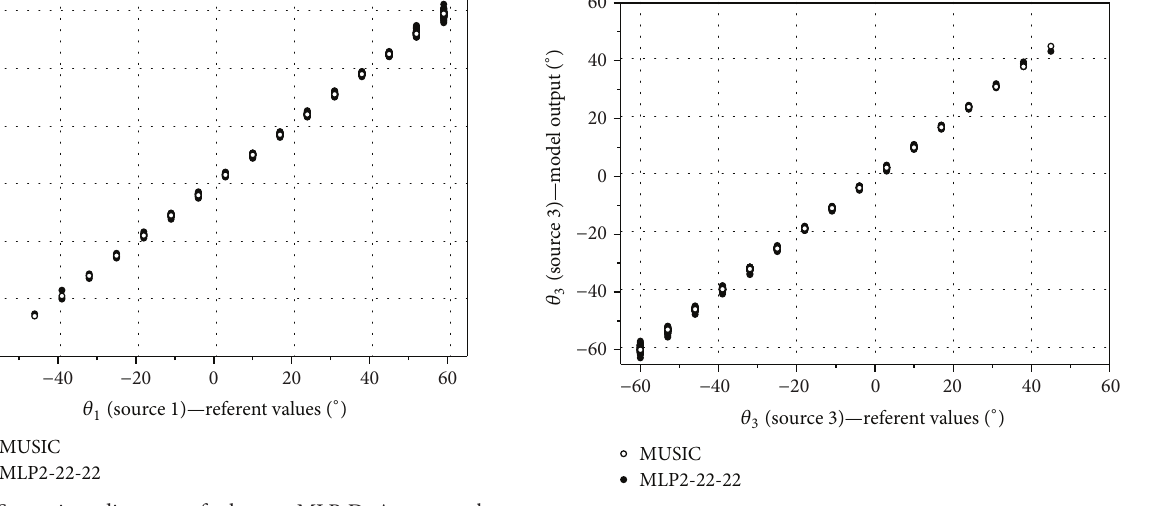
Figure 10: Scattering diagram of chosen MLP-DoA 3 network (MLP2-22-22) and the MUSIC model for output 3 (source 3) obtained by simulation on the test set (Case 𝑠 = 3